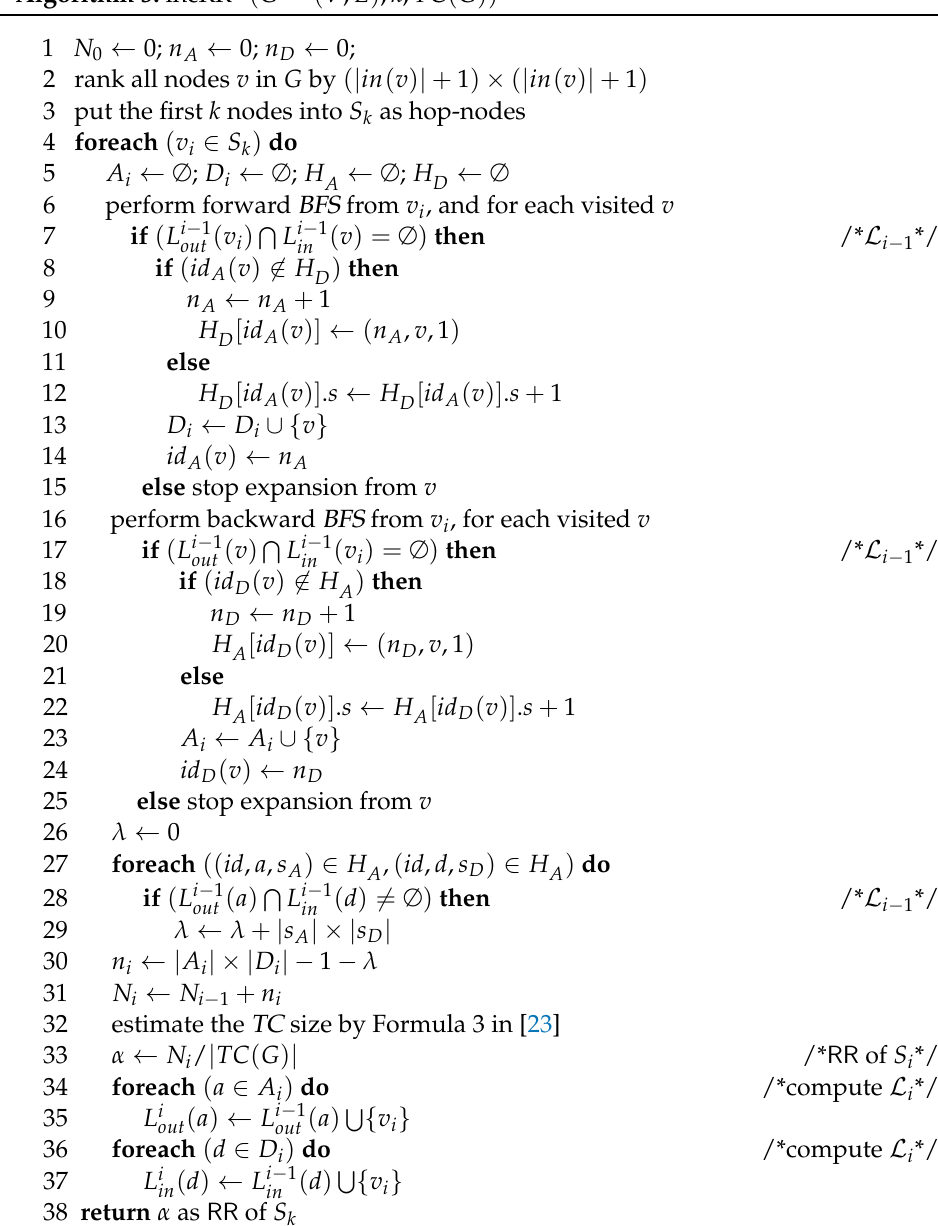
Algorithm 3: incRR + ( G = ( V , E ) , k , TC ( G